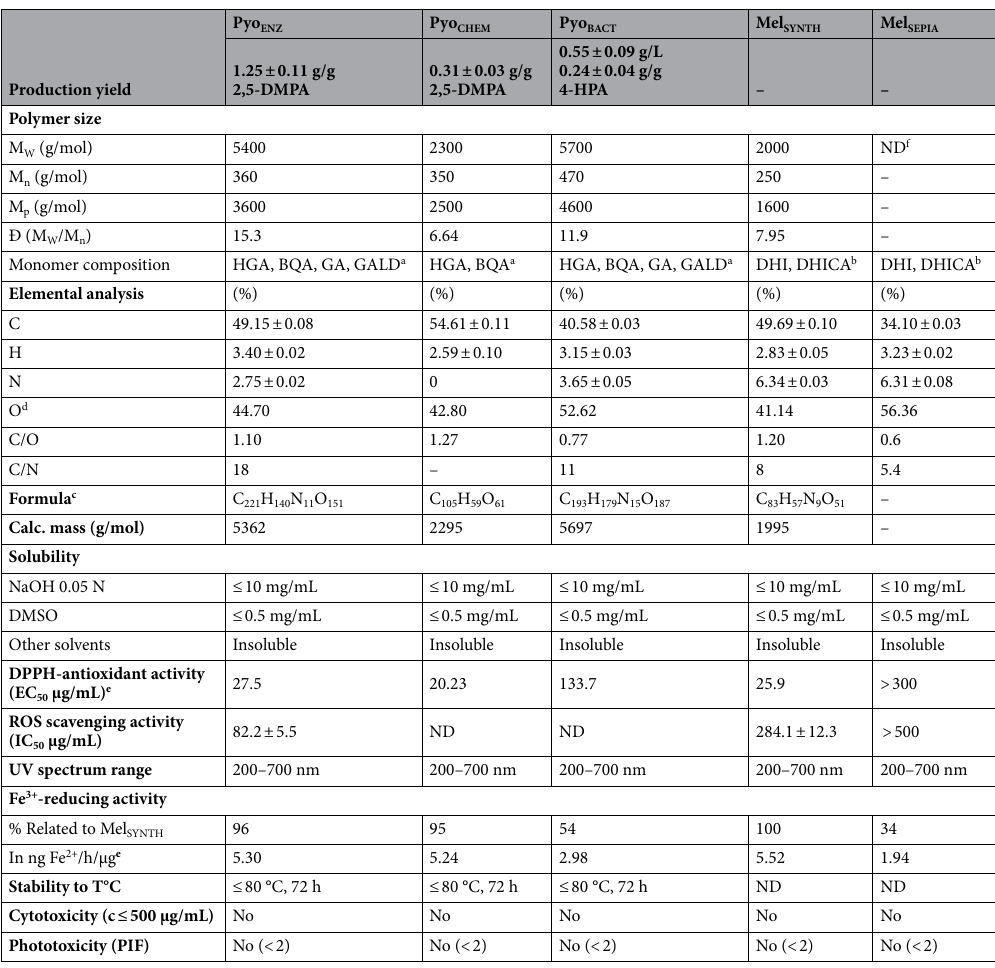
Table 2. Summarized chemical and biological properties of pyomelanin and commercial melanin. Since the A 400 nm value of solubilized pyomelanin depends on the size of the pigment, a spectrophotometric quantification by surrogate melanin for calibration will not be correct. Weighing precisely the final purified pigment remains the only valuable technique for the quantification of pyomelanin as well as other melanin. a Identified by 13 C solid-state NMR (Fig. 2 and Table 1). b To confirm the global structure of Mel Mel SEPIA , assays on their degradation by alkaline-H 2 O 2 were conducted similarly to those on human melanin 41 . After centrifugation, 10 μL of the reaction volume was injected into an RP-HPLC(DAD)-QToF system in negative mode and confirmed the L-Dopa melanin structure by the presence of the two markers PTCA and PDCA. c Elemental analysis (C, H, N, S) of the pigments was performed by combustion on a Thermo Finnigan EA 1112 analyzer equipped with an autosampler, all managed by the Eager Xperience software (THERMO SCIENTIFIC, France). The oven was set at 970 °C and the flash combustion at 1800 °C. In the formula C x H y N z , each index was deduced by (x, y, z) = %atom (data from elemental analysis) x M w /M atom . d The index w (for oxygen O Mel SYNTH was similar to those described 63 , that of Mel SEPIA close to the reported values 42 (see sample Com). f Molecular weight of the S. officinalis melanin could not be determined on the MCX column eluted in the same conditions (see Fig. 6S). GA, gentisyl alcohol; GALD, gentisaldehyde; ND, not